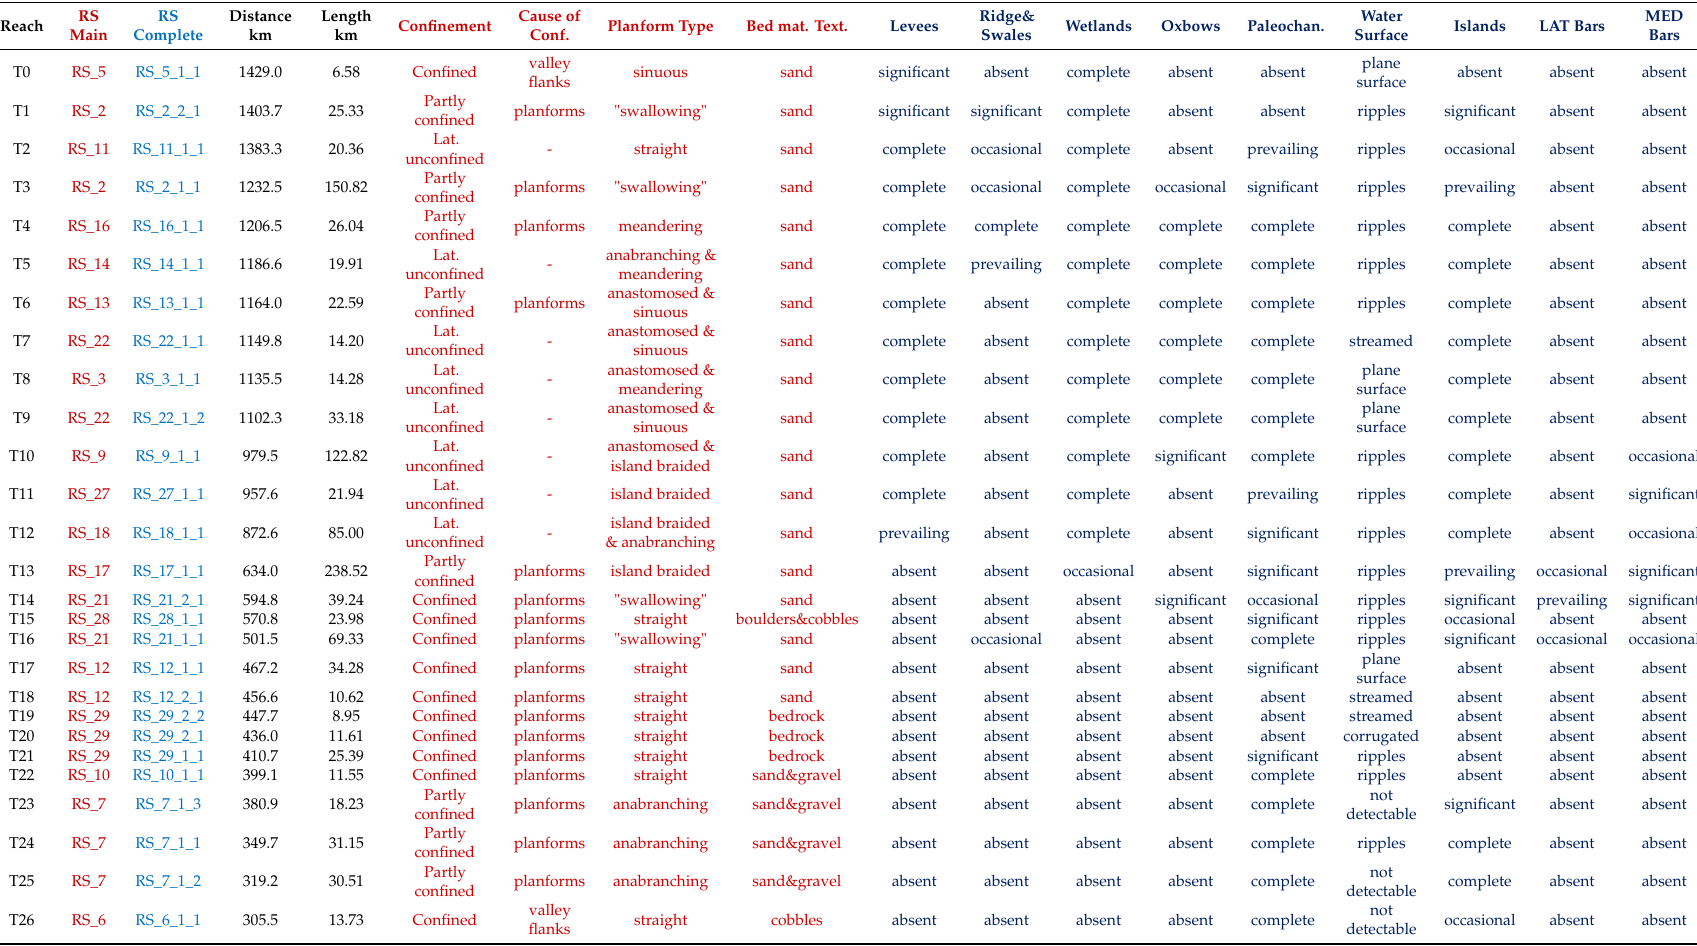
Table 1. River Styles of each Reach (Tx) and value of all relevant attributes obtained for the Magdalena River (only Betania Reservoir appears as the new one—El Quimbo—was not yet considered in the o ffi cial SHP files adopted). Red color denotes fundamental attributes; while blue is used for the accessory attributes related to geomorphological units. The main River Styles (RS main) only consider the former, while RS full also includes the